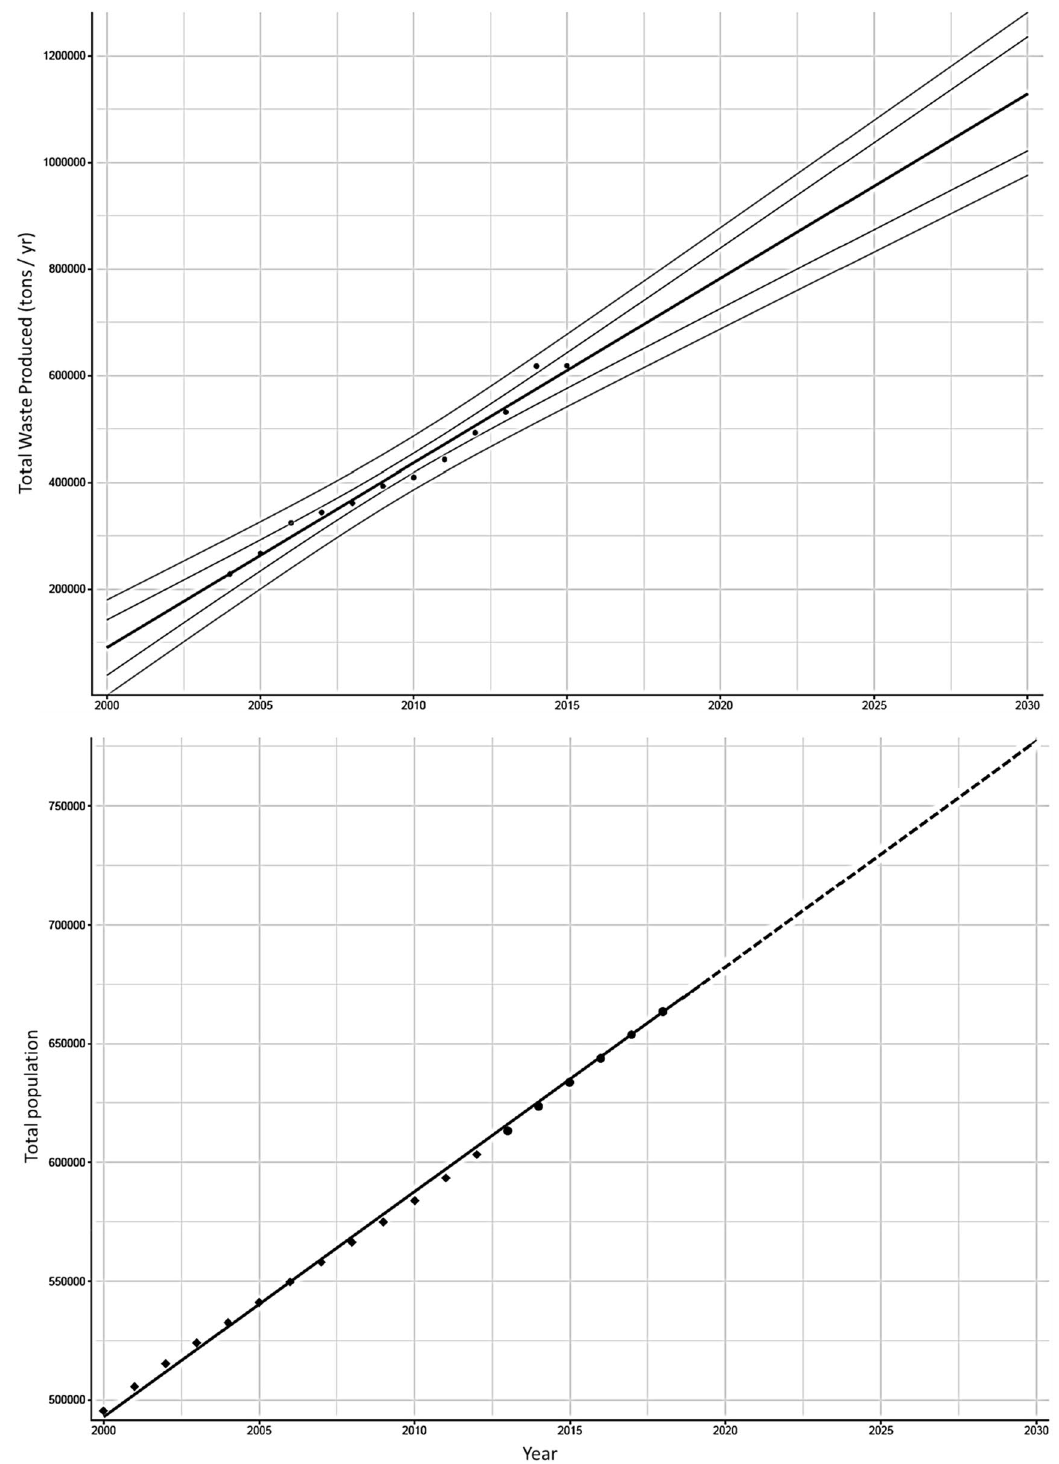
Figure 3. (top) Total waste disposed of in tons per year in Phnom Penh, between 2004 and 2015 28 . Data has been projected forwards and backwards between 2000 and 2030 (black line), with prediction and confidence interval at 95%. (bottom) Total Cambodian population from 2000 to 2018 54 . Total population is projected forward from 2019 to 2030, using the years 2013 to 2018 (dashed